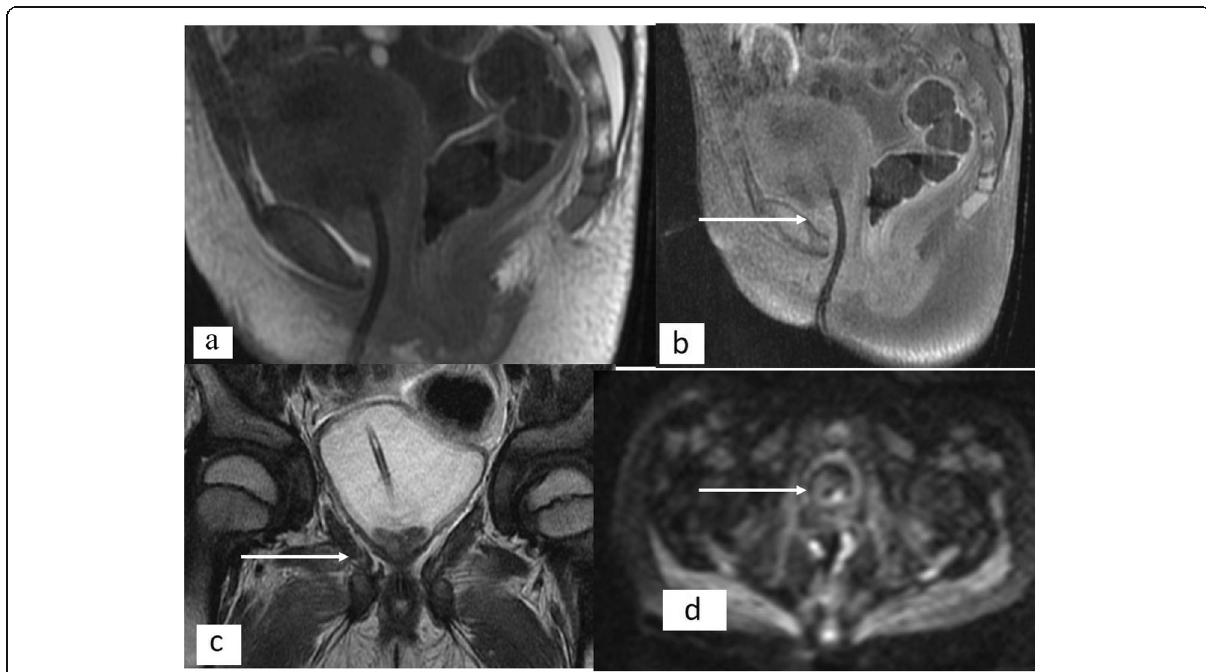
Fig. 2 Sagittal T1W image ( a ), T2W coronal image ( b ), and T2W FS axial image through the pelvis show polypoidal lesion arising from the bladder base (arrow in a , b , and c ). The lesion is hypo- to isointense on T1W and mildly hyperintense on T2W with no suppression on fat- suppressed images. Patchy areas of diffusion restriction are seen (arrow in d )